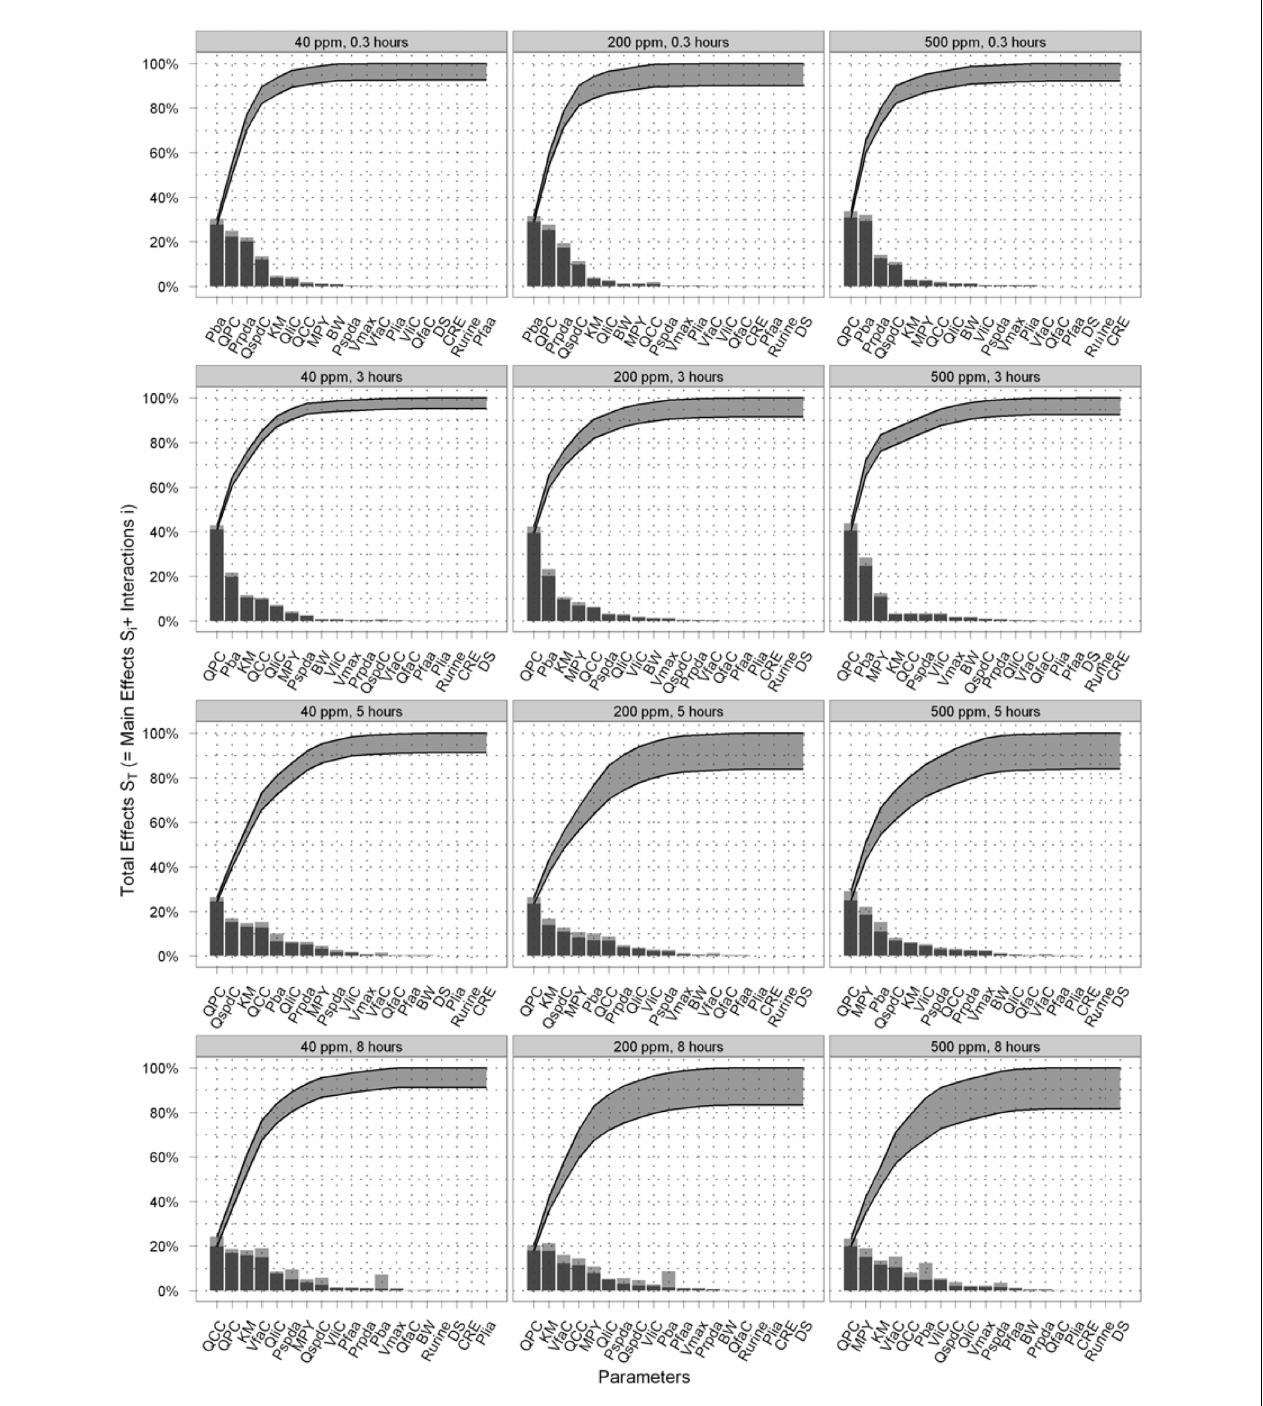
FIGURE 5 | Selected latticed Lowry plots showing concentration and time-dependent changes in parameter interactions and ordering.